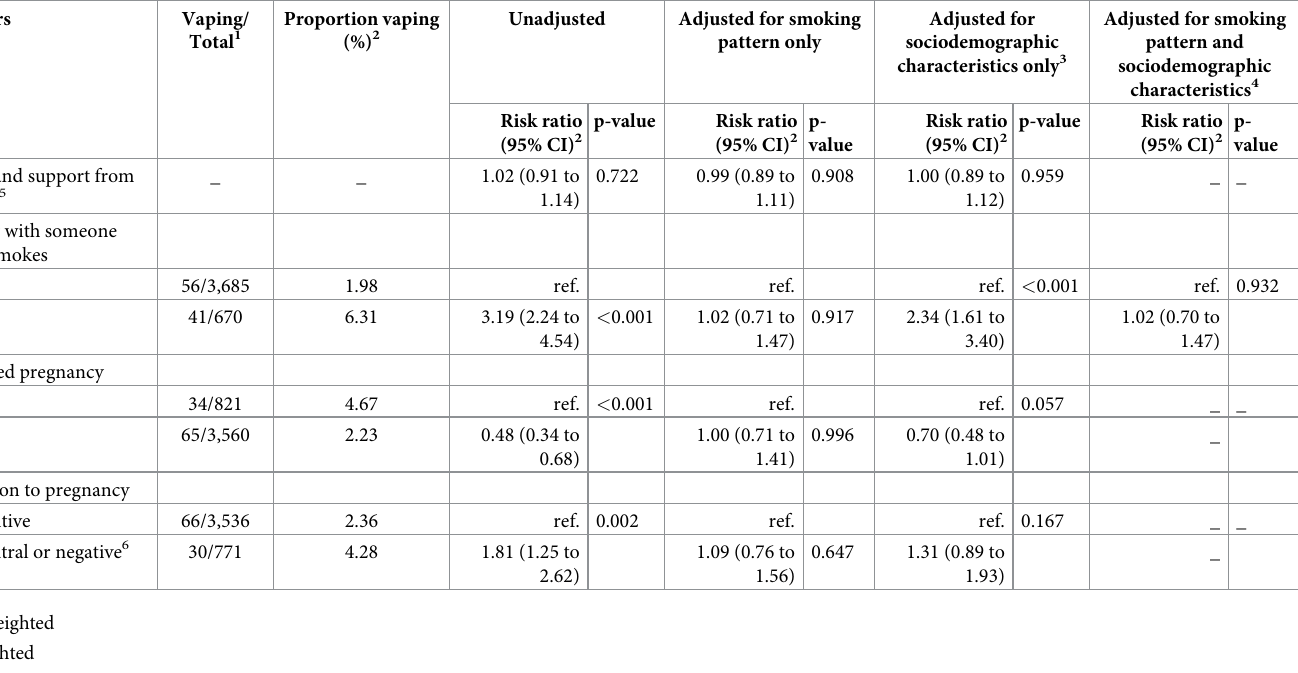
Table 3. Pregnancy-related factors associated with vaping.